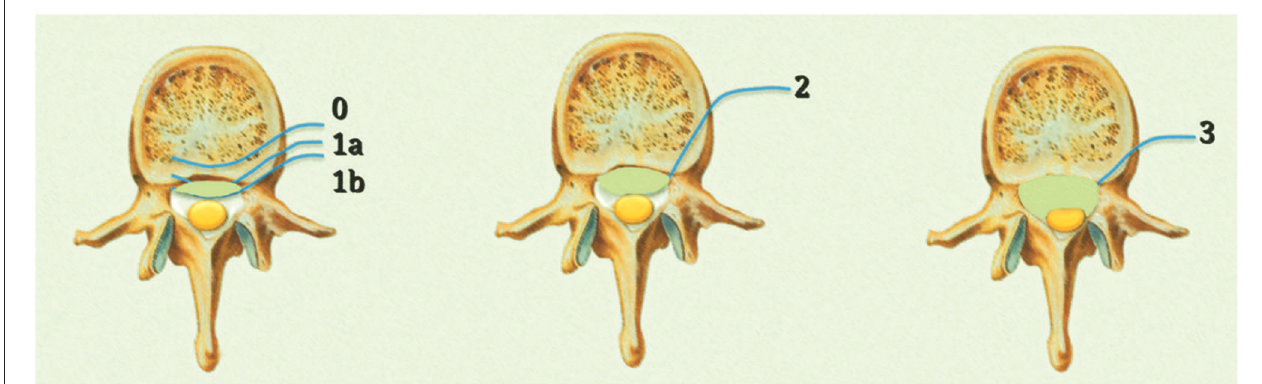
FIGURE 1 | Bilski classification of epidural spinal cord compression (ESCC).